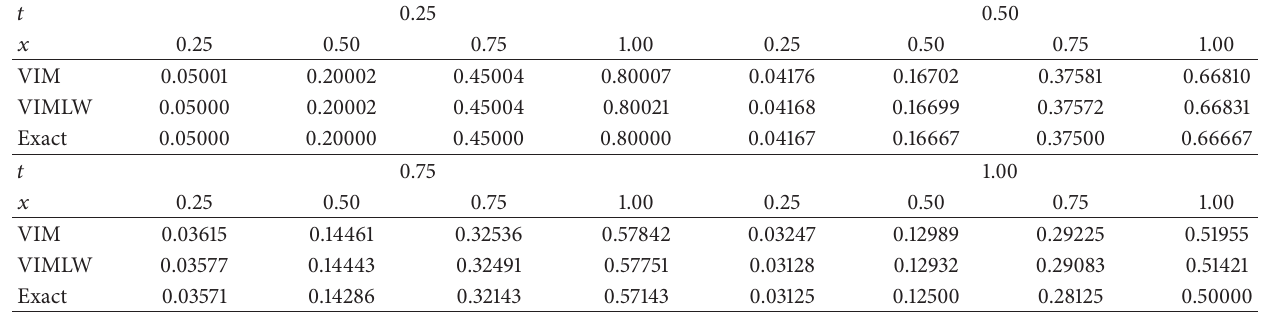
Table 2: Numerical values when 𝑡 = 0.25 , 0.50, 0.75, and 1.0 for (54).